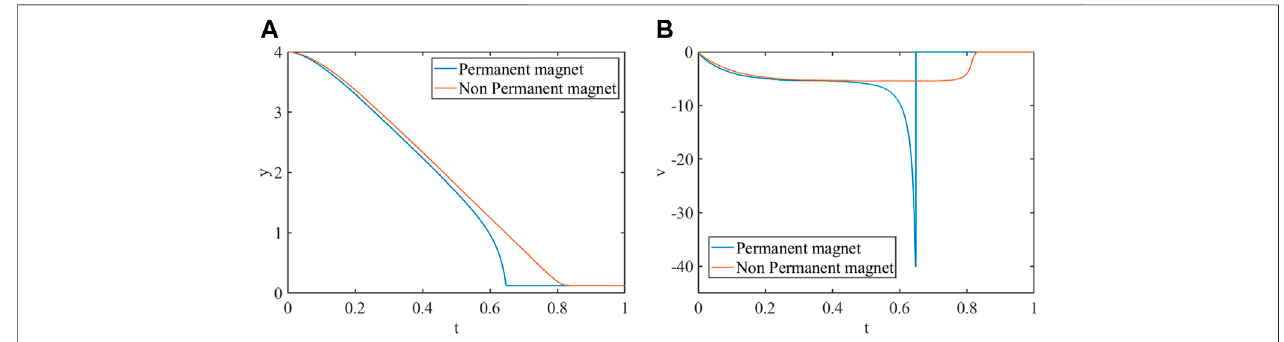
FIGURE 10 | Position (A) and velocity (B) of the center of the particle for ρ p (cid:2) 1 . 25 g / cm 2 and ] (cid:2) 0 . 1 cm 2 / s .